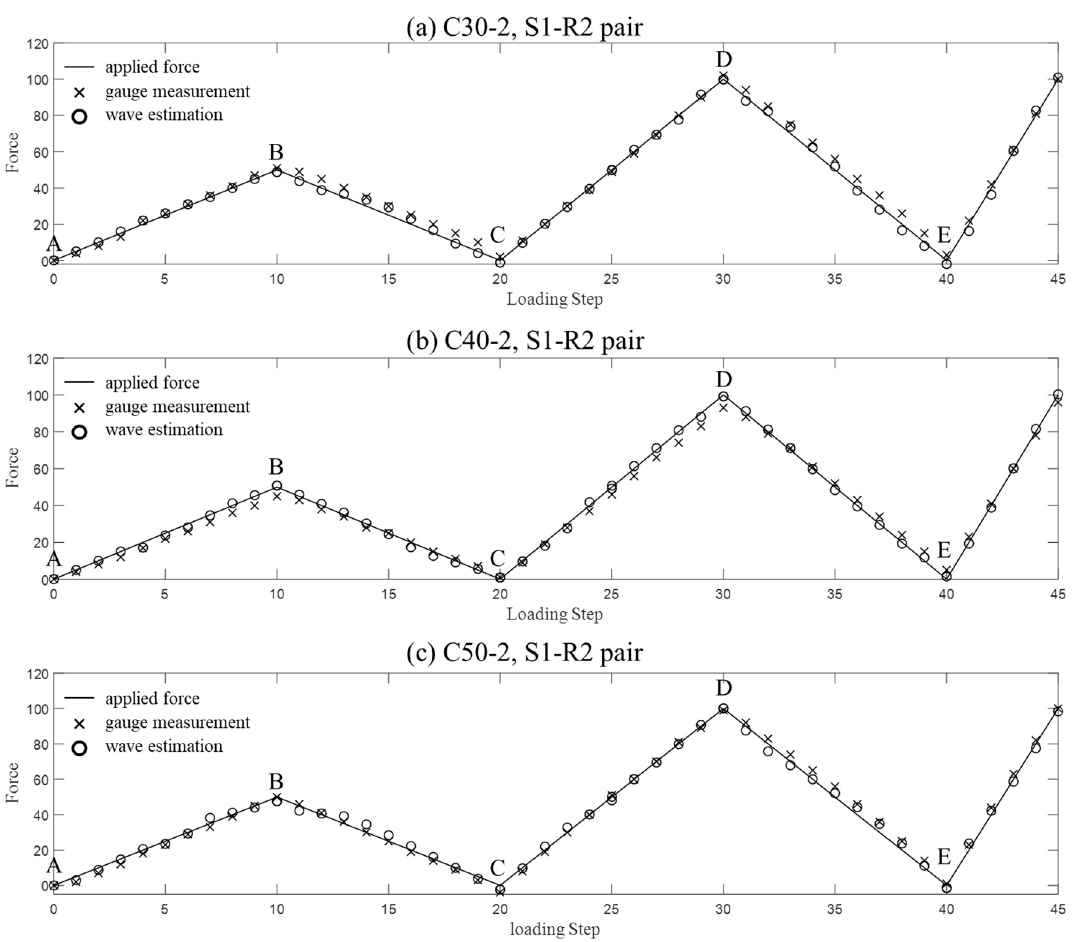
Figure 6. The applied (line), measured (x) and estimated (circle) stress values for the concrete samples of: ( a ) C30-2, ( b ) C40-2 and ( c ) C50-2.